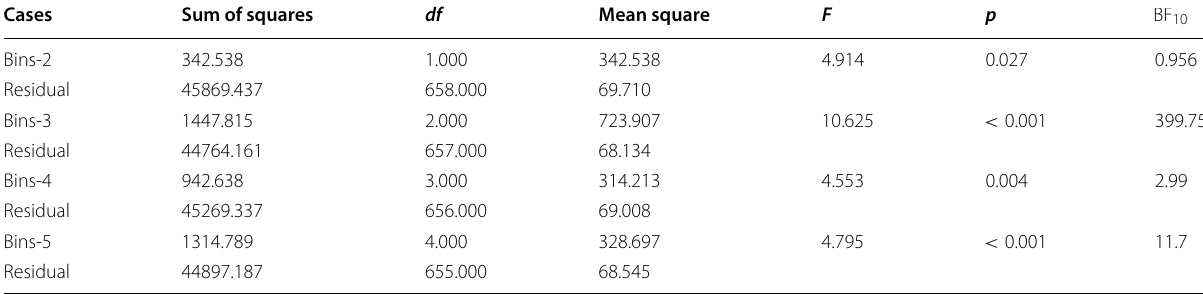
Table 4 Summary of ANOVA results—fixed discrete